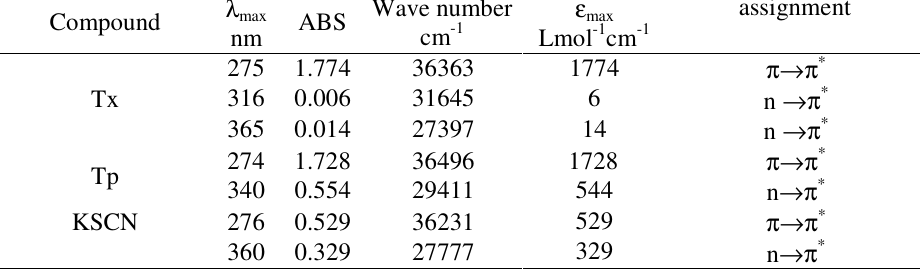
Table 4. UV Visible spectra of free ligands and their complexes 10 -3 M in